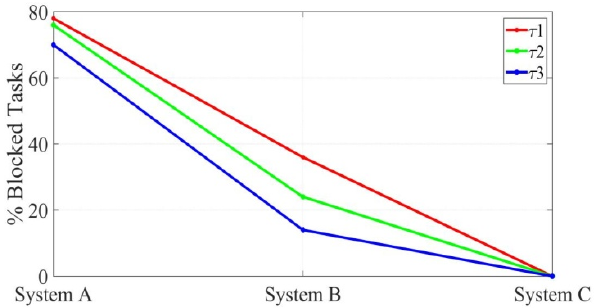
Figure 15. System comparison in terms of task blocking.